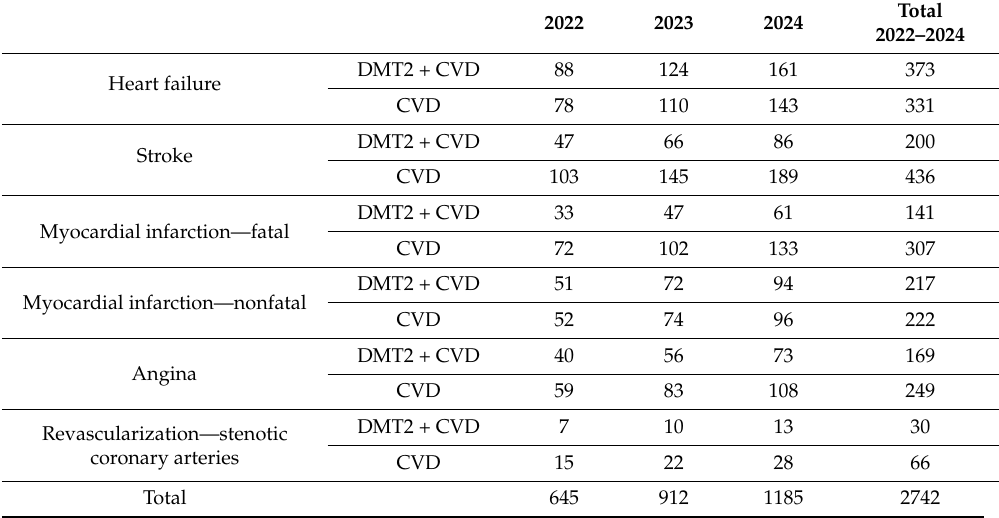
Table 12. Number of avoided unwanted events in the eligible population ( n = 138,308).